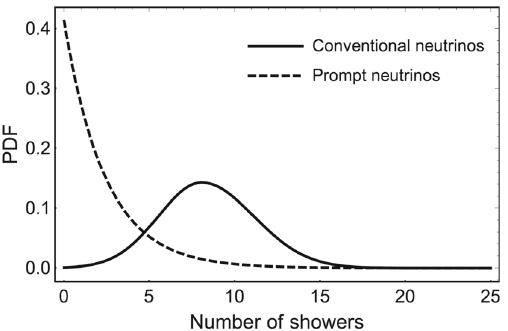
Fig. 3 The expected contribution of the atmospheric background to HESEshowersin7.5yearsofexposure.Thesolidcurvedenotesthecon- tribution expected from atmospheric neutrinos and atmospheric muons [10], while the dashed curve denotes the contribution expected from prompt neutrinos